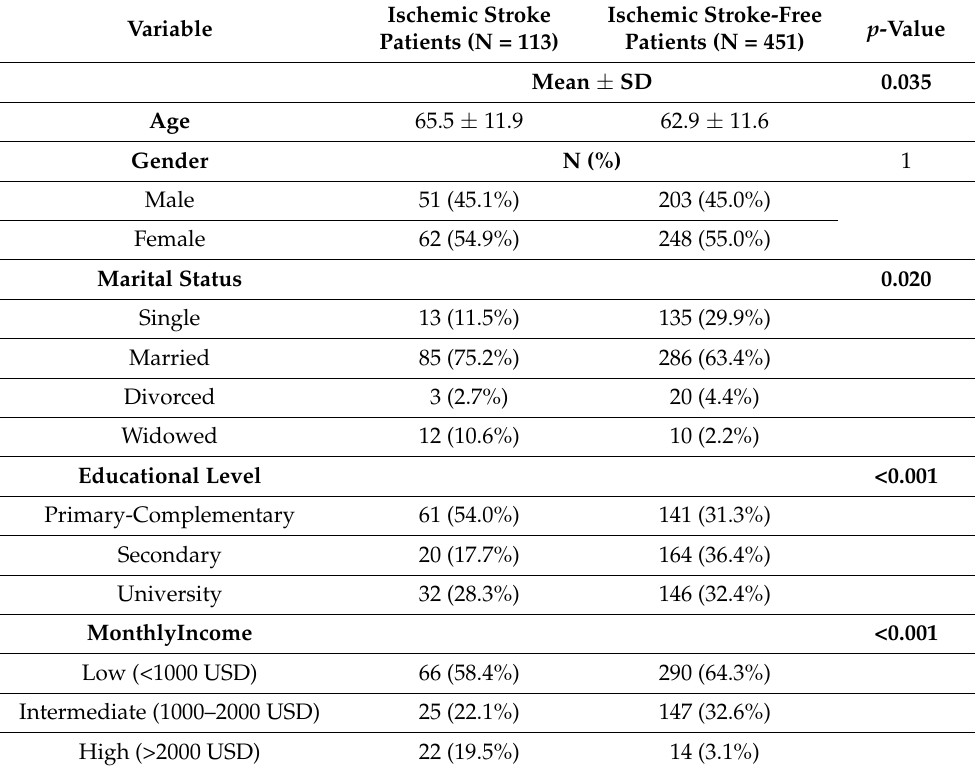
Table 1. Bivariate analysis of demographic factors associated with ischemic stroke.